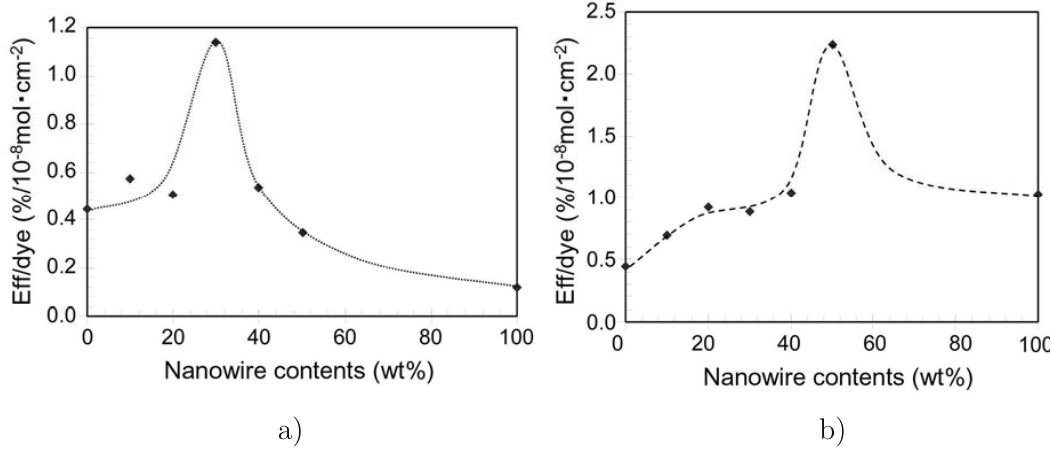
Fig. 11 Variation of normallized efficiency (%) per dye concentration vs nanowire content: (a) TiO 2 (B), and (b) TiO 2